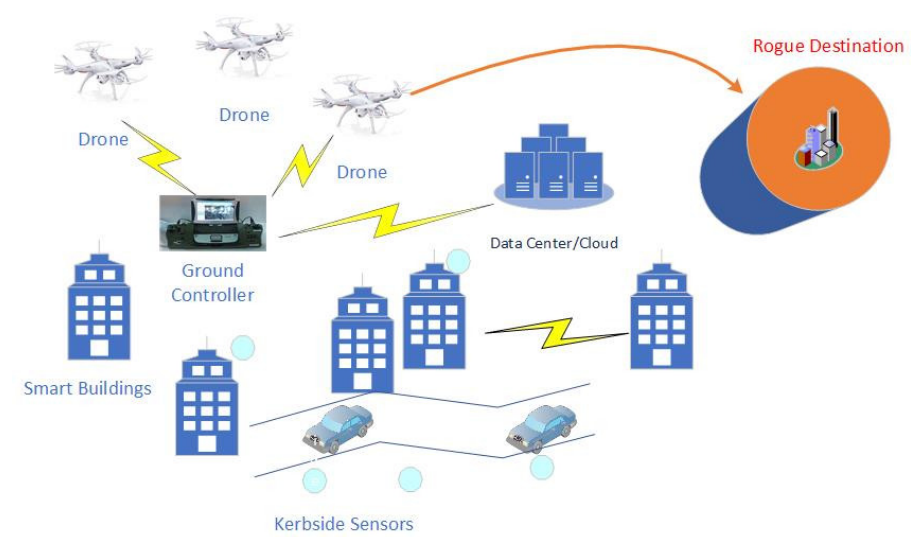
Figure 1. Smart city with drones—illustration of a potential